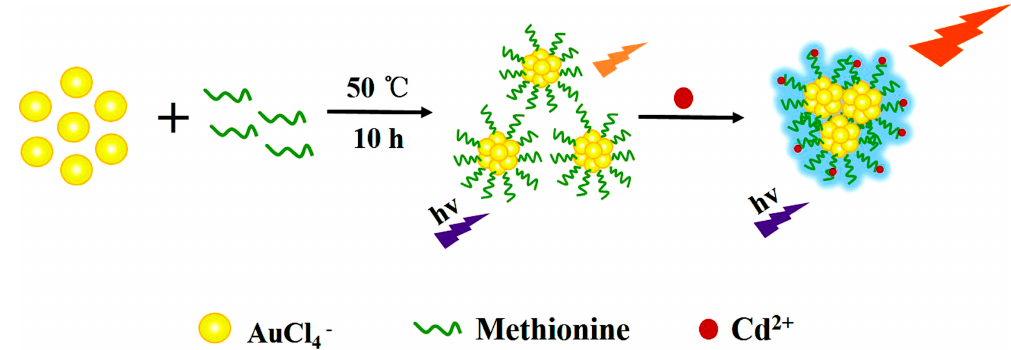
Figure 1. Schematic illustration of the Gold nanoclusters’ (Au NCs) formation and the Cd 2+ induced fluorescence enhancing of Au NCs.